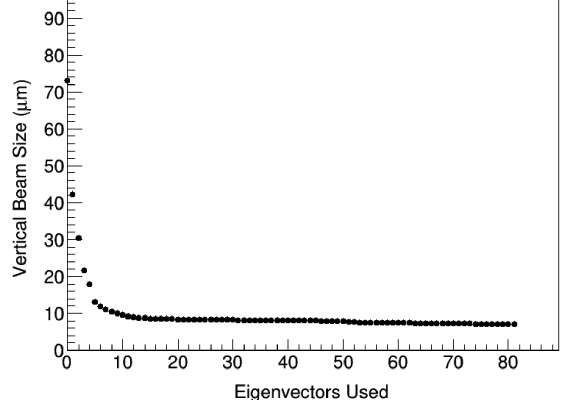
FIG. 3. The average simulated beam size over 1000 instances of a lattice with random misalignments after minimizing the beam size using our first N eigenparameters. The average initial beam size is shown by the point lying on the vertical axis. Note the rapid decrease in beam size from the first few eigenparameters.